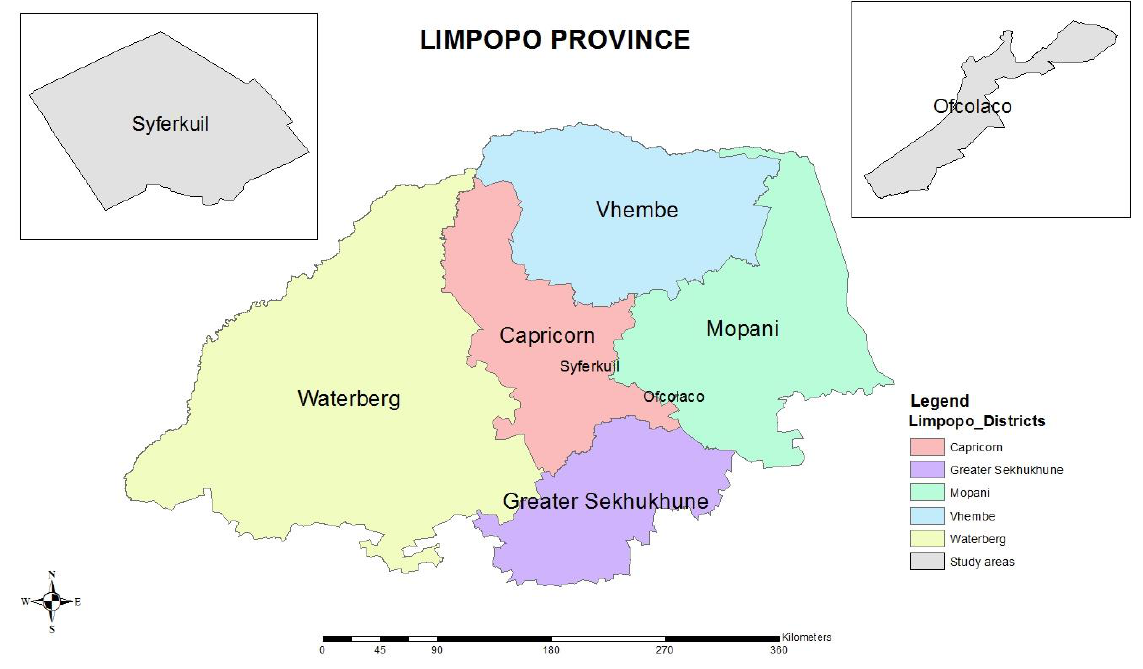
Figure 1. Locality map of the study sites.